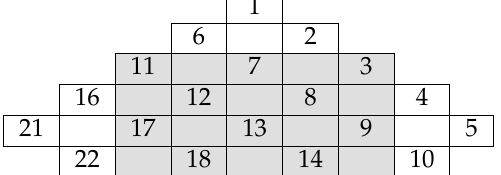
Figure 1. A 3 × 3 square.